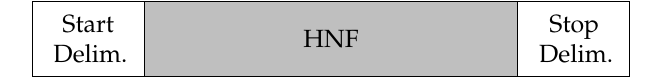
Figure 8. Visible light communication (VLC) packet structure with the HNF as payload.